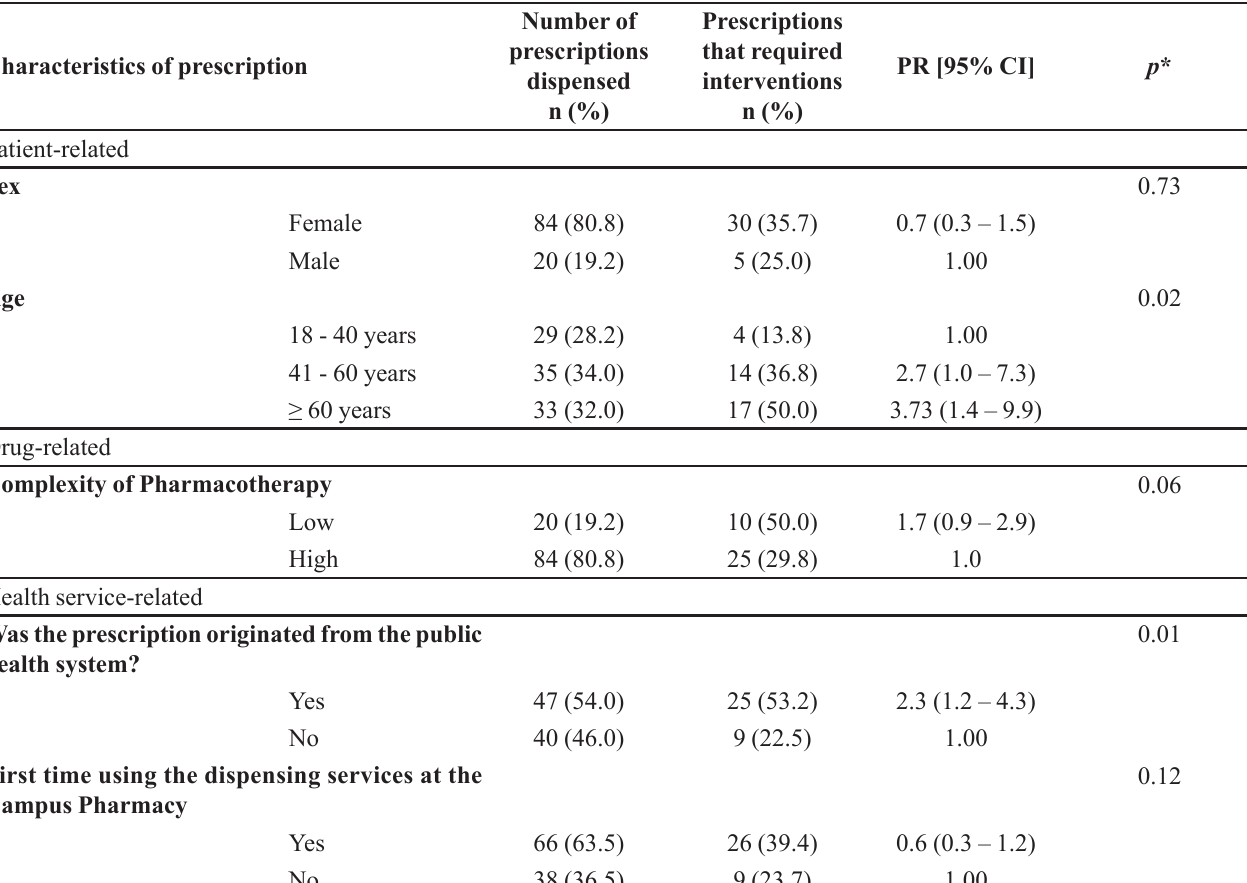
TABLE IV - Pharmaceutical interventions and associated factors performed during the dispensing process at the Campus Pharmacy, Goias, Brazil, 2013